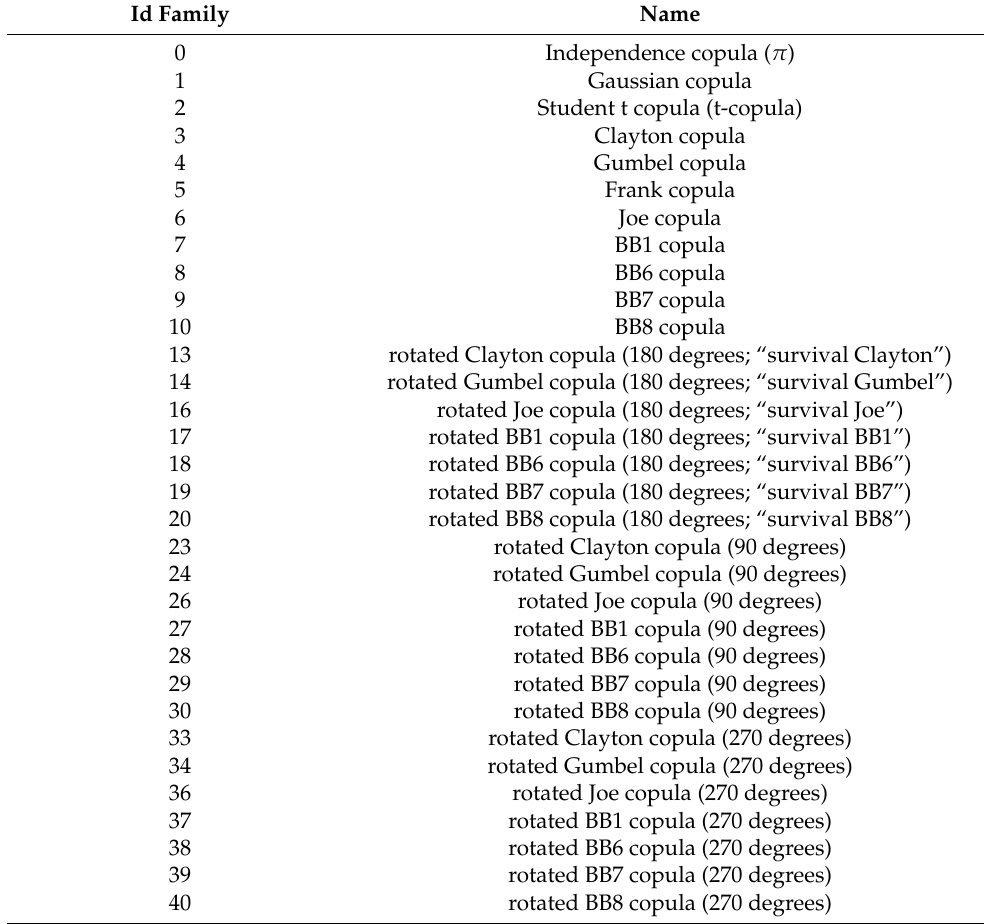
Table A1. Copula families of VineCopula R-package considered in